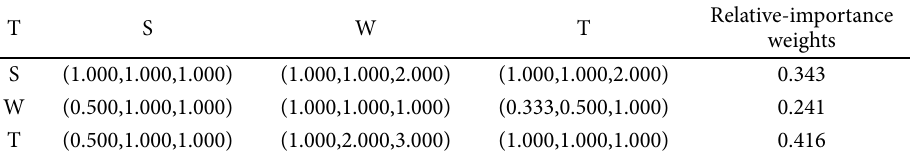
Table 6. The relative-importance weights for the “T” group